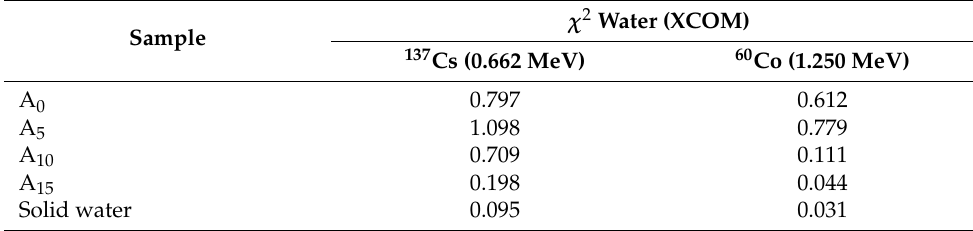
Figure 5. RAPs of DSF-based composite phantoms, water (XCOM), and solid water phantom against gamma energies: ( a ) MAC, ( b ) HVL, and ( c ) MFP. Table 5. χ 2 values for MAC of DSF-based R. spp. particleboards and solid water